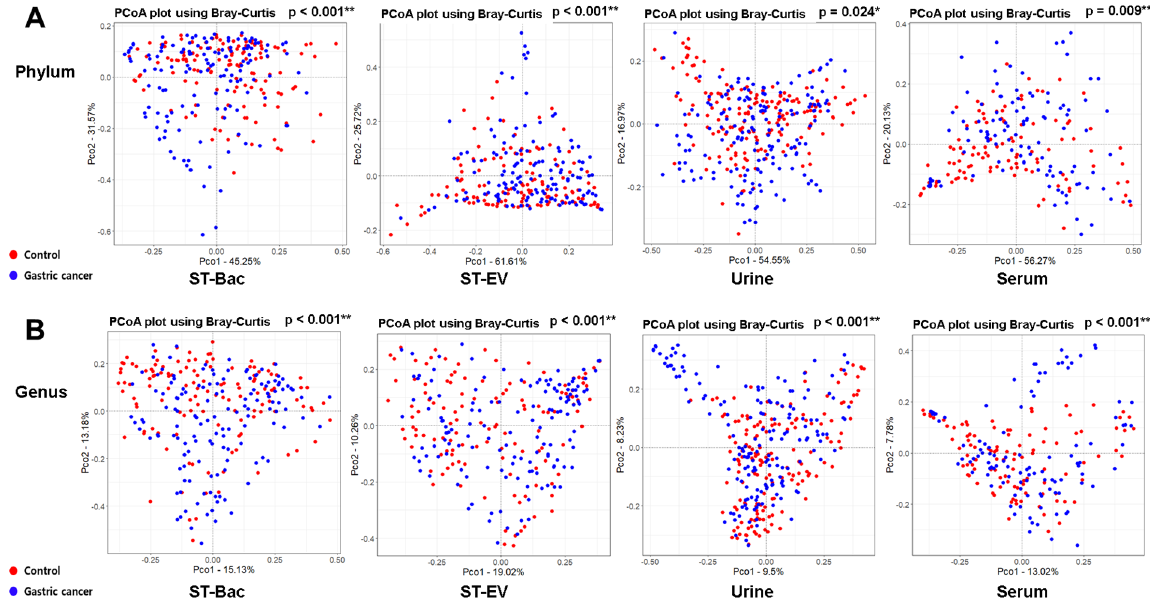
Figure 2. Comparison of beta diversity in phylum and genus levels between healthy controls and gastric cancer patients in 4 sample types. PCoA results based on Bray–Curtis similarity for beta diversity of bacteria are shown ( A ) in phylum level and ( B ) in genus level.